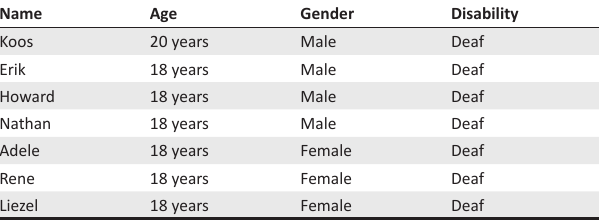
TABLE 2: Participant group 2: Secondary high school for the deaf.